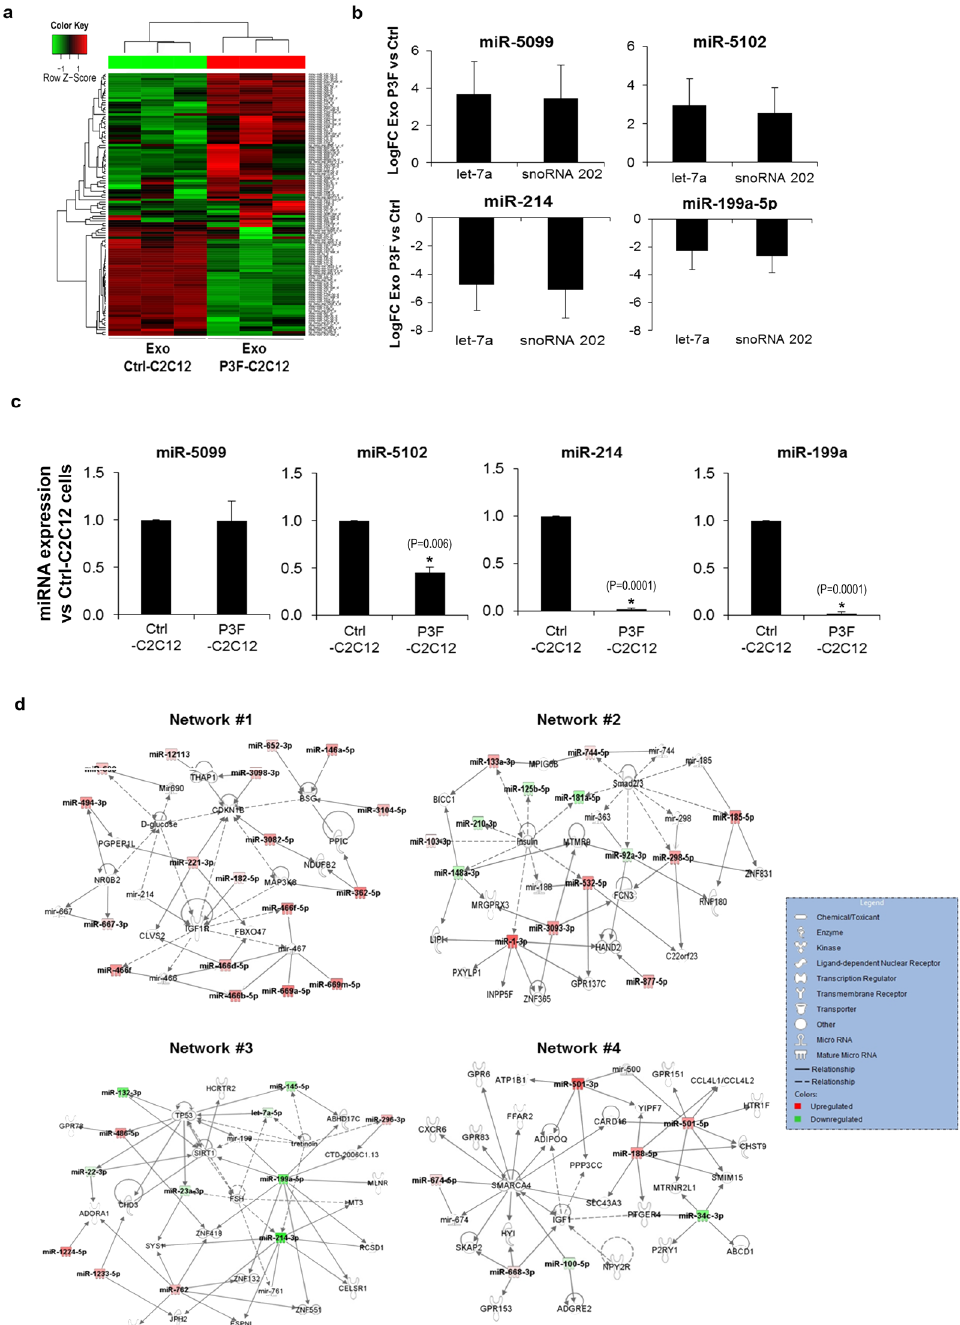
Figure 3. PAX3-FOXO1 fusion oncoprotein alters the miRNA content of exosomes. ( a ) Hierarchical clustering of the deregulated miRNA P3F-C2C12 derived exosomes compared to Ctrl-C2C12 derived exosomes. Each column represents an exosome isolated replicate, and each row represents a miRNA. The scaled expression of each miRNA, denoted as the row Z-score, is plotted in green–red color scale. High expression levels are indicated in green and low expression levels are shown in red. ( b ) Histograms representing mean log fold change (logFC) of the indicated miRNA in P3F-C2C12 versus Ctrl-C2C12 derived exosomes. Results are shown using two different endogenous controls (Let-7a and snoRNA202), as indicated. Values are means of 3 independent exosome preparations, each run in duplicates. Bars represent standard deviation. ( c ) Histograms representing indicated miRNA levels in P3F-C2C12 cells versus Ctrl-C2C12 cells, normalized to snoRNA202 expression detected by qRT-PCR analysis. Values presented are means of three independent experiments. Bars represent standard deviation. Asterisks denote a statistically significant difference (p-value < 0.05). ( d ) IPA Network analysis of deregulated exosomal miRNA due to PAX3-FOXO1 transduction in C2C12 cells reveals 4 networks that contain more than one identified focus miRNA. These networks were generated through the use of IPA (QIAGEN Inc.,